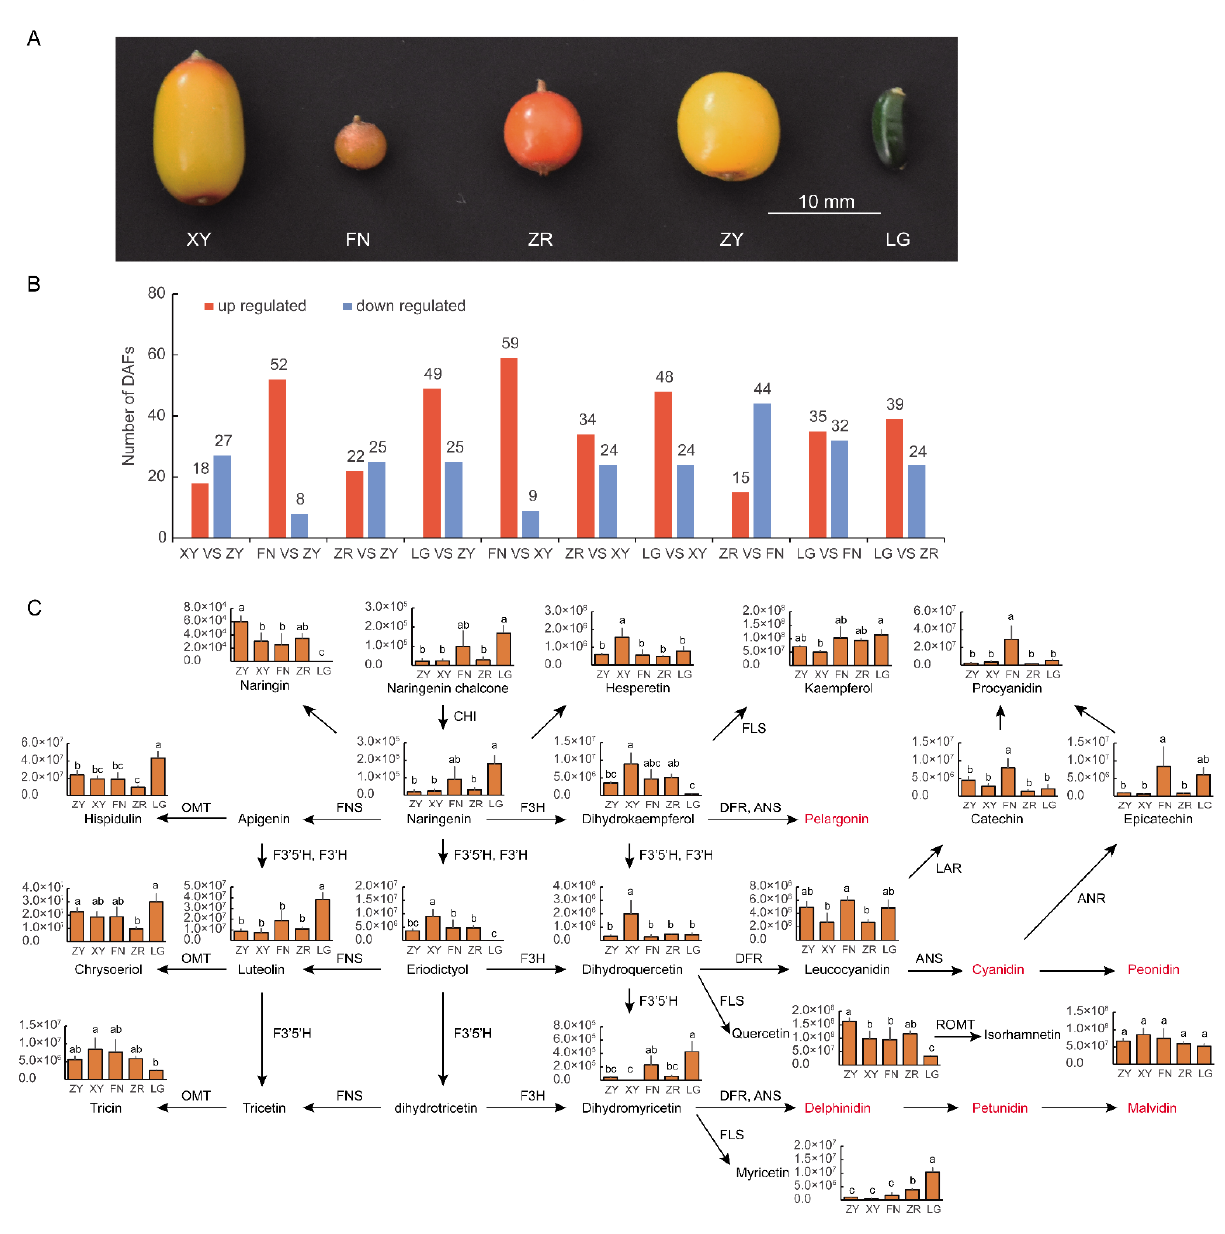
Figure 1. Fruit colors and quantification of flavonoids in the fruits of five sea buckthorn varieties: ( A ) colors of ripe sea buckthorn fruit: XY, FN, ZR, ZY, LG; ( B ) numbers of differentially synthesized flavonoids between five sea buckthorn varieties; ( C ) flavonoid levels in the fruits of five sea buckthorn varieties. Each bar represents the average of three biological replicates plus the standard deviation. The significant difference between the data were evaluated via one-way ANOVA and labeled using different letters ( p <